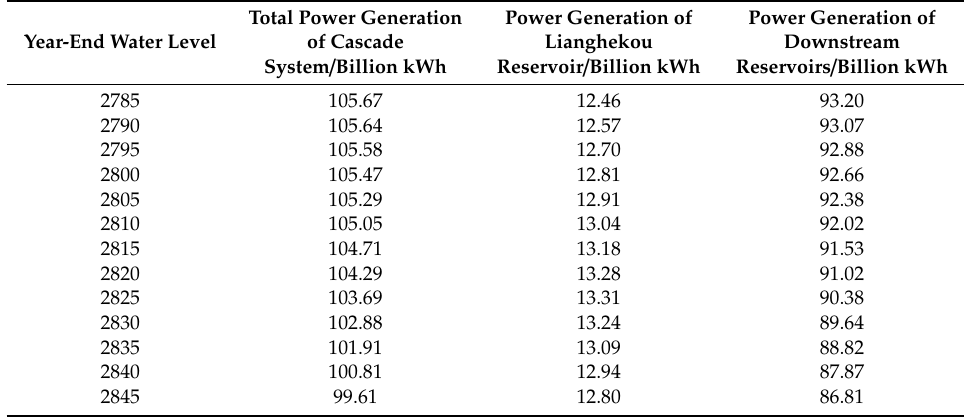
Table5. Calculationresultsofnormalyearunderdi ff